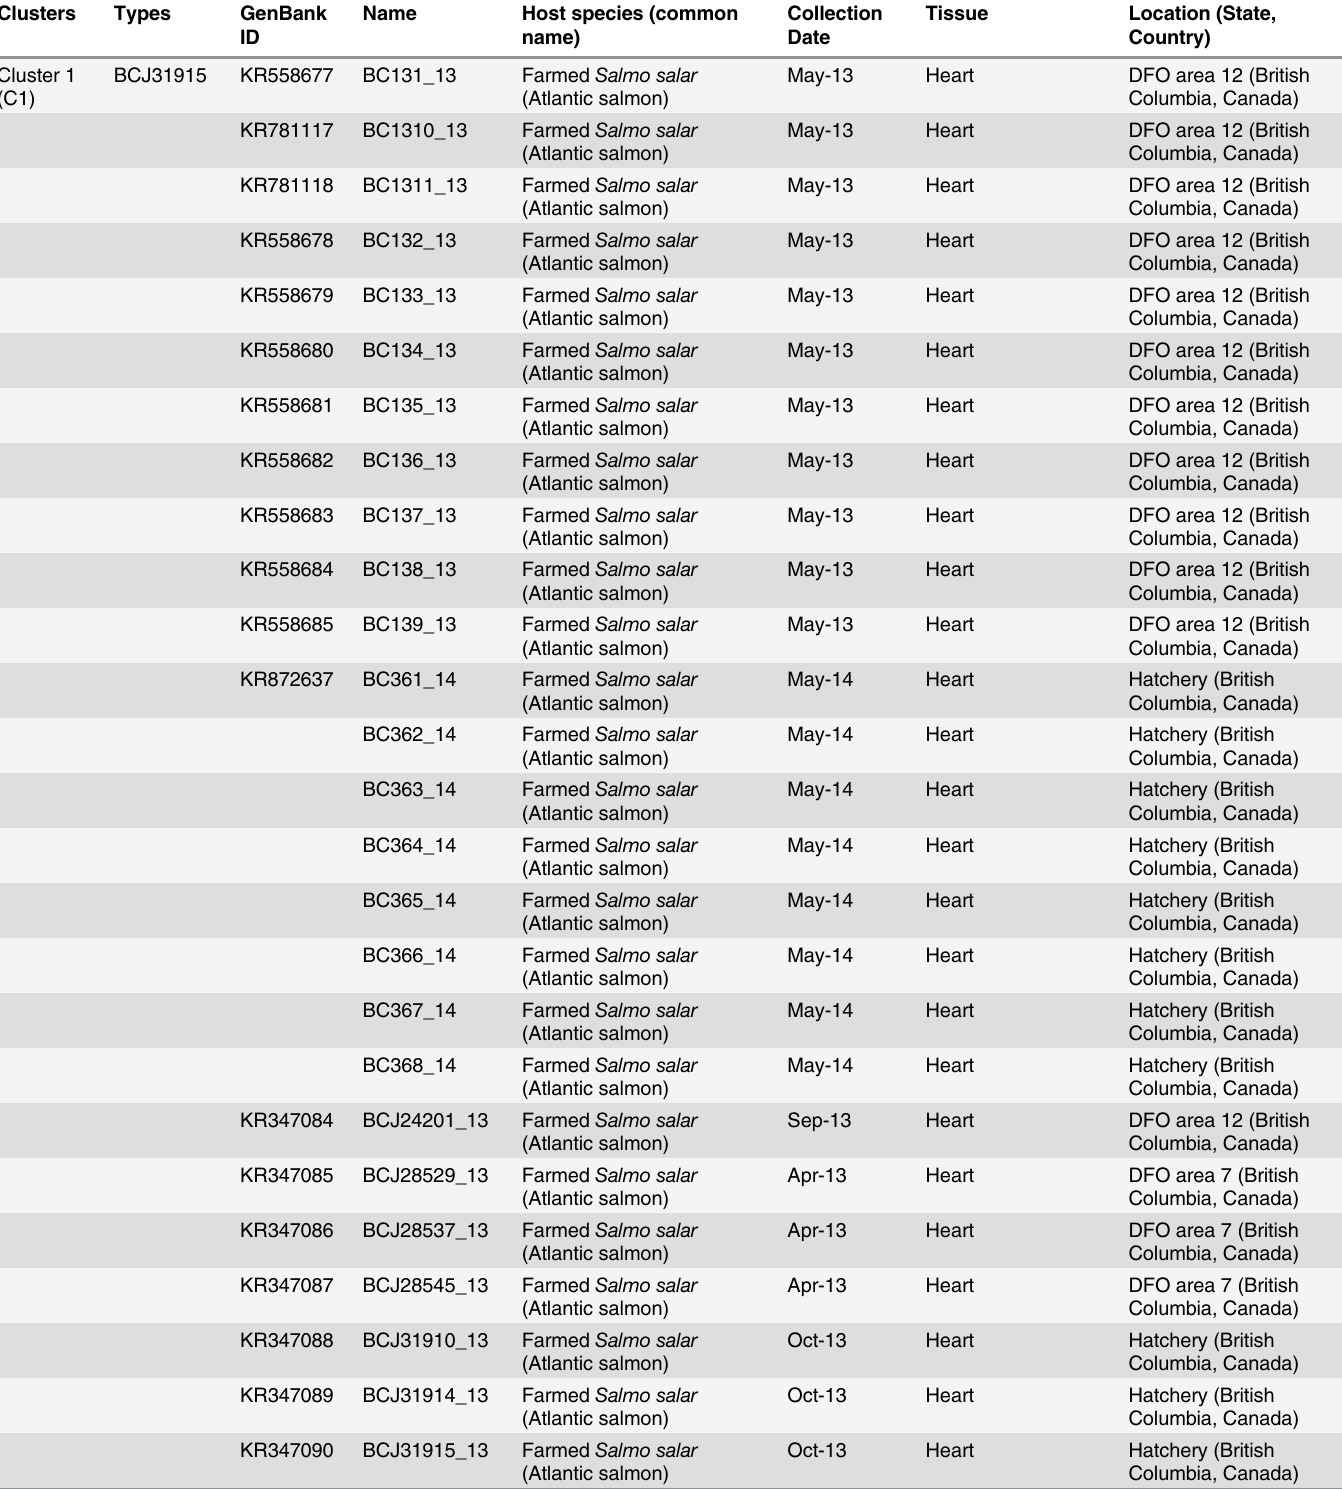
Table 2. Information on partial segment S1 sequenced from fish samples collected in Alaska, British Columbia and Washington State. Ten types of identical sequences have been identified and grouped in five clusters.